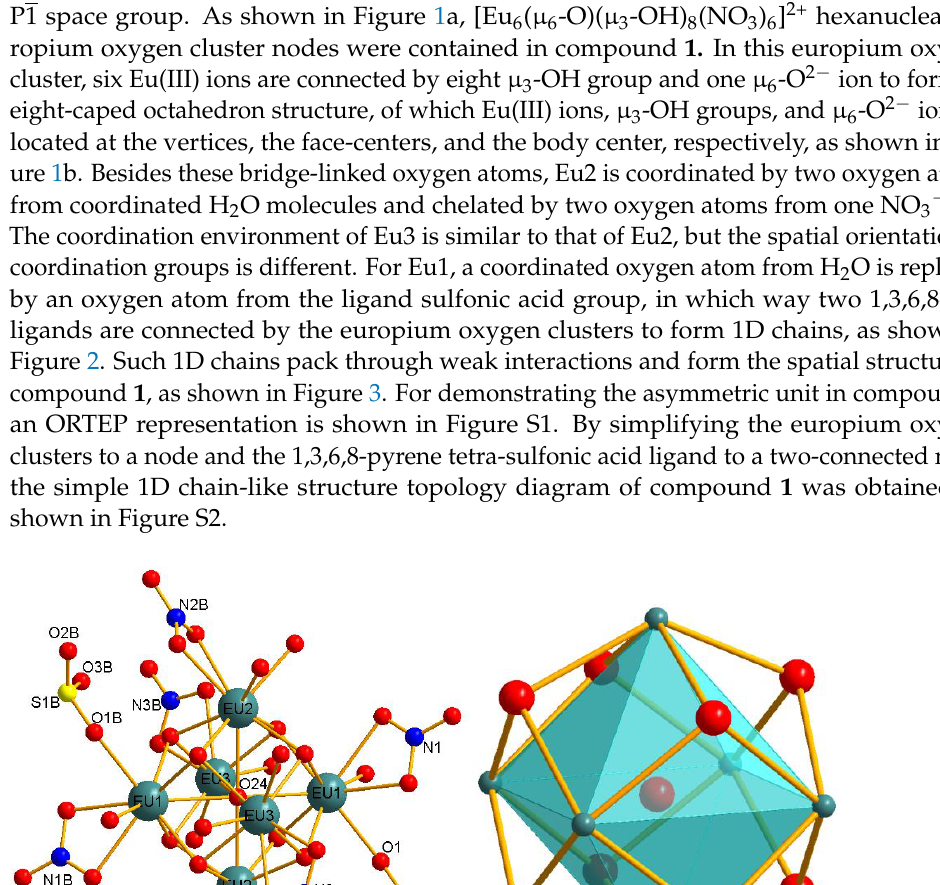
Figure 3. The packed chain-like structure in compound 1 along the a direction. 3.1.2. Eu(NO 3 )(1,3,6,8-PTS) 0.5 (H 2 O) 3 · 0.5bipy ( 2 ) According to the single crystal X-ray diffraction data, compound 2 belongs to the triclinic P 1̅ space group. As shown in Figure 4, each Eu(III) ion is coordinated with three oxygen atoms (O1, O2, and O4) from two sulfonic acid groups of 1,3,6,8-pyrene tetra-sul- fonic acid ligands and three oxygen atoms (O10, O11, and O12) from coordinated H 2 O molecules, and is chelated by two oxygen atoms from one NO 3- ion, showing an eight- coordinate configuration. For demonstrating the asymmetric unit in compound 2 , an OR- TEP representation is shown in Figure S3. A 2D layered structure is formed by the 1,3,6,8- pyrene tetra-sulfonic acid ligands connecting the Eu(III) ion nodes, as shown in Figure 5. The sulfonic acid groups of pyrene tetra-sulfonic acid ligands are coordinated with Eu(III) ions in two different modes. One is to connect one Eu(III) ion node in a  1 way, and the other is to connect two Eu(III) ion nods in the form of  2 -  2 mode. By simplifying the 1,3,6,8-pyrene tetra-sulfonic acid ligand to a four-connected node, the layered structure topology diagram of compound 2 can be obtained, as shown in Figure 5b. The Schläfli symbol can be expressed as (3 33  4 33 ).